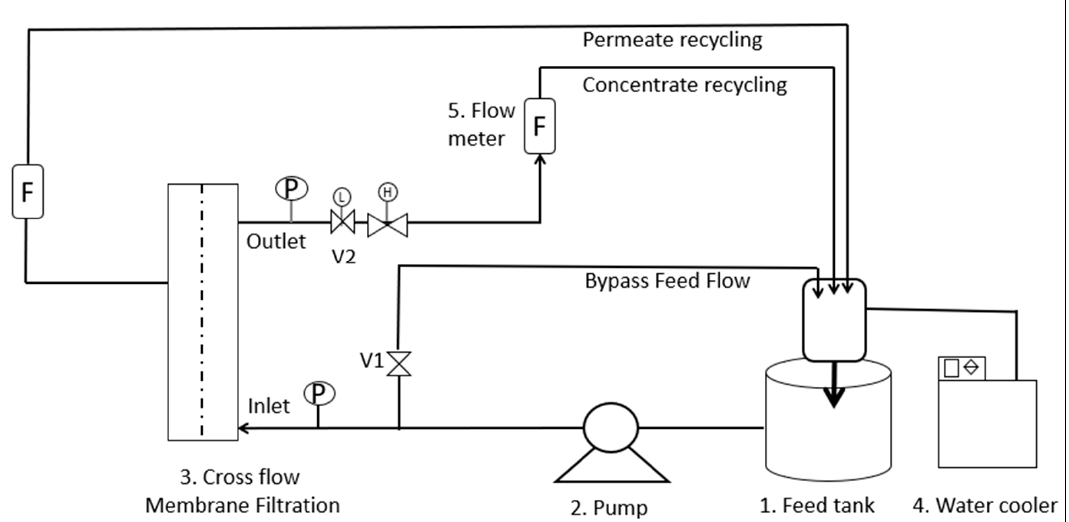
Figure 1. Crossflow filtration setup used for the pure water permeability and scaling tests [8,14].